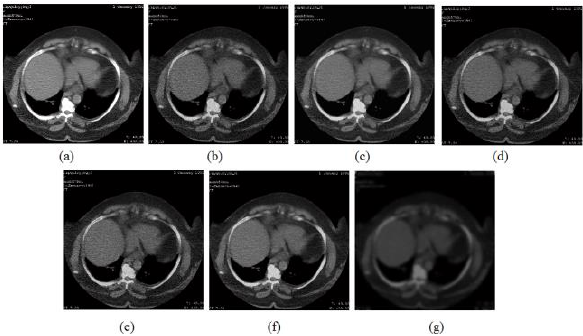
Figure4: (a) Original CT sample image, (b) Noisy image, Denoised images by: (c) PURE-LET, (d) MS-VST, (e) Exact unbiased inverse of the VST, (f) Total variation, (g) PDE-based